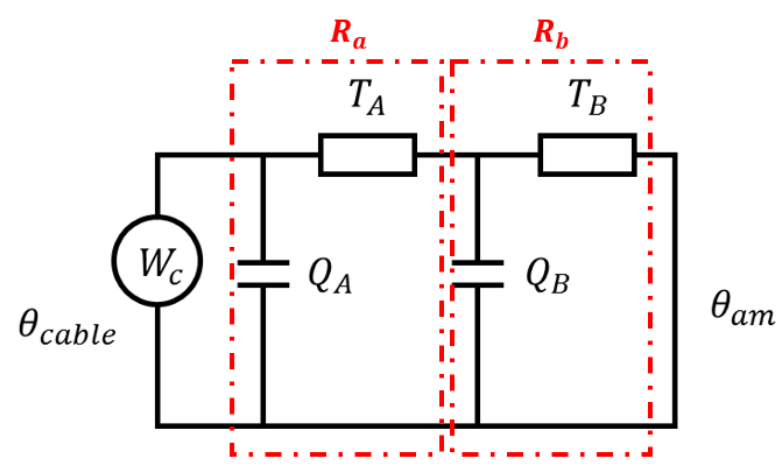
Figure 2. The two-loop equivalent thermal ladder representation [31].